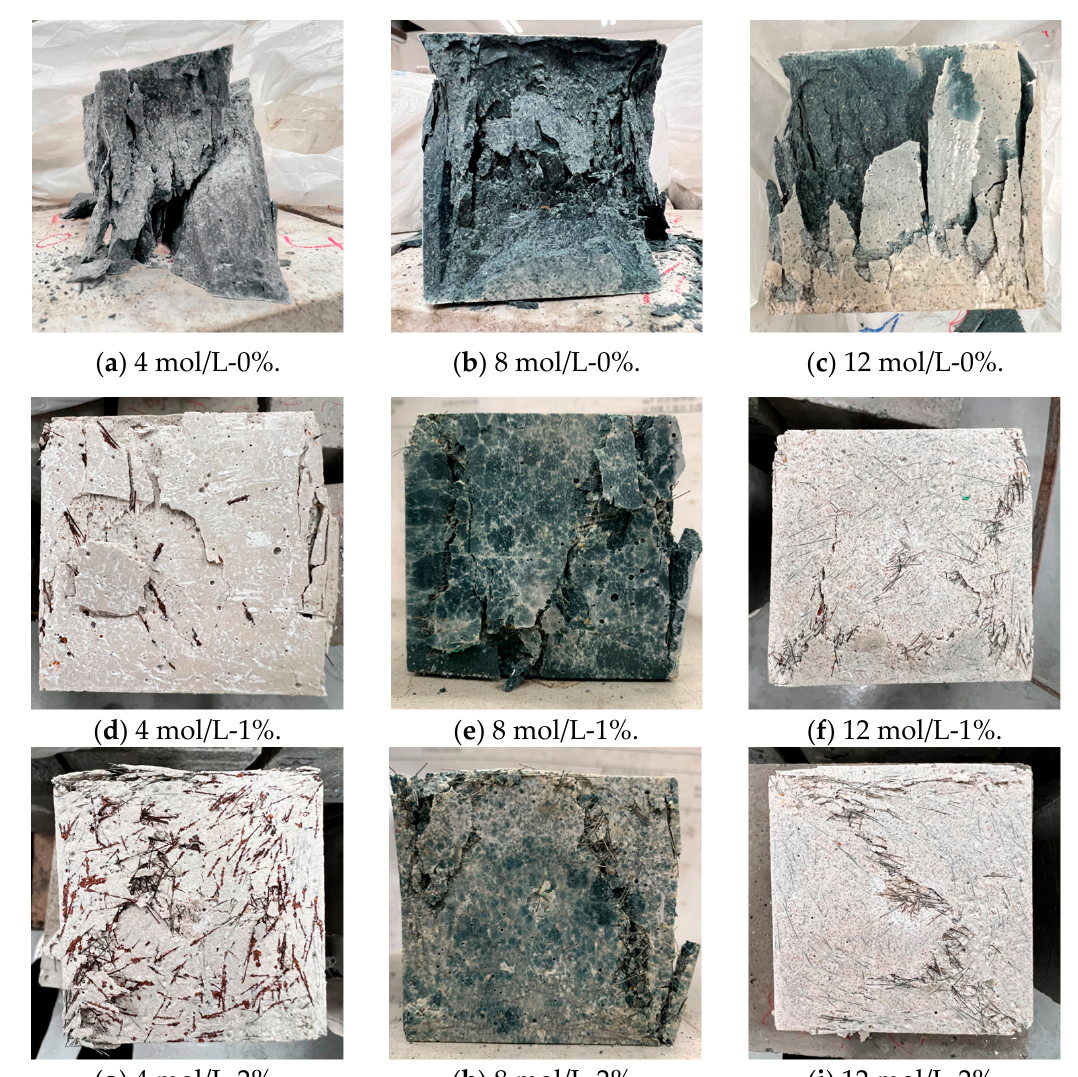
Figure 4. Typical failure modes under uniaxial compression.